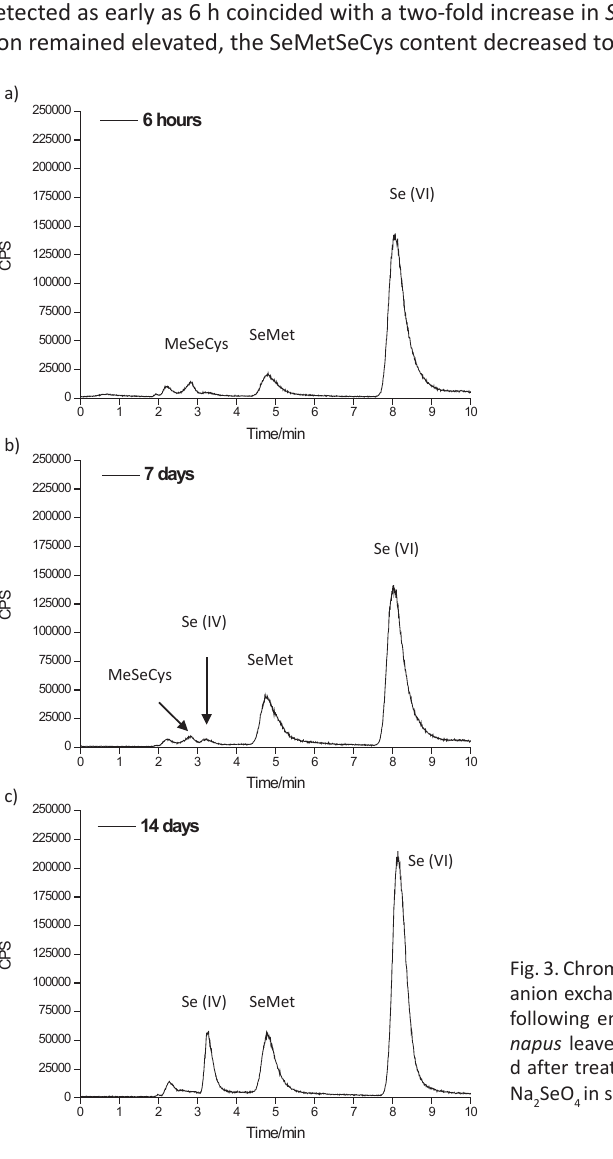
Fig. 3. Chromatographic profiles obtained by anion exchange with HPLC-ICP-MS for 80Se following enzymatic extraction of Brassica napus leaves at (a) 6 h, (b) 7 d and (c) 14 d after treatment with 130 µg Se plant -1 as Na SeO in soil alone; 2 4